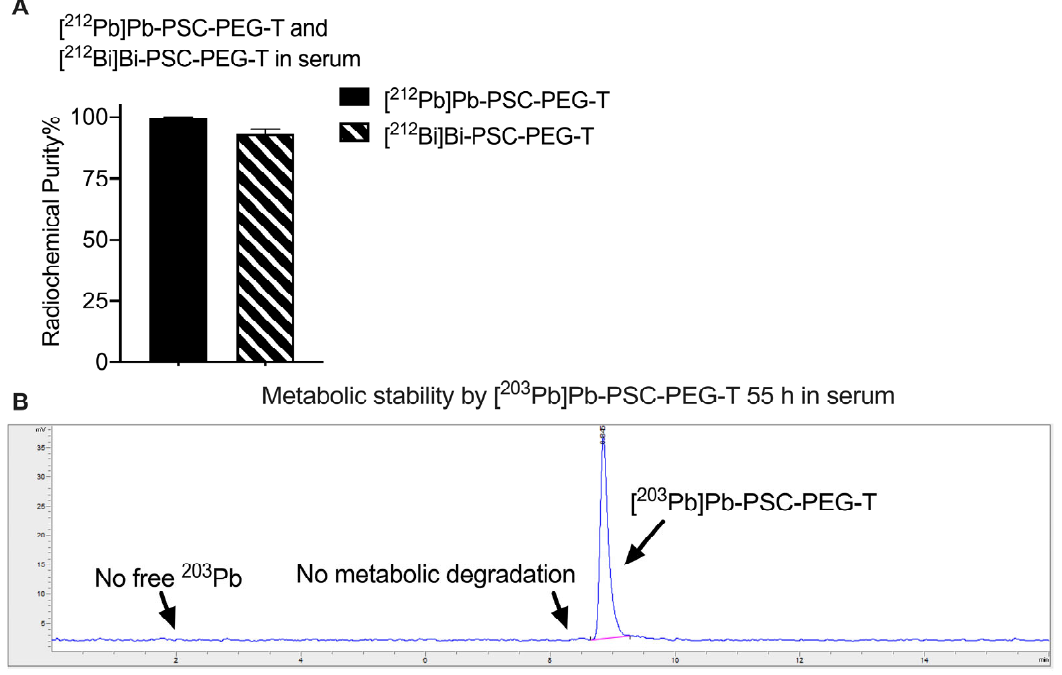
Figure 4. Stability of Pb-PSC-PEG-T in human serum. (A) Radio-iTLC analysis of radiochemical purity of [ 212 Pb]Pb-PSC-PEG-T and progeny [ 212 Bi]Bi-PSC-PEG-T after incubation in serum for 24 h (n = 2); (B) Representative radio-HPLC chromatogram of [ 203 Pb]Pb-PSC-PEG-T incubation in serum for 55 h.